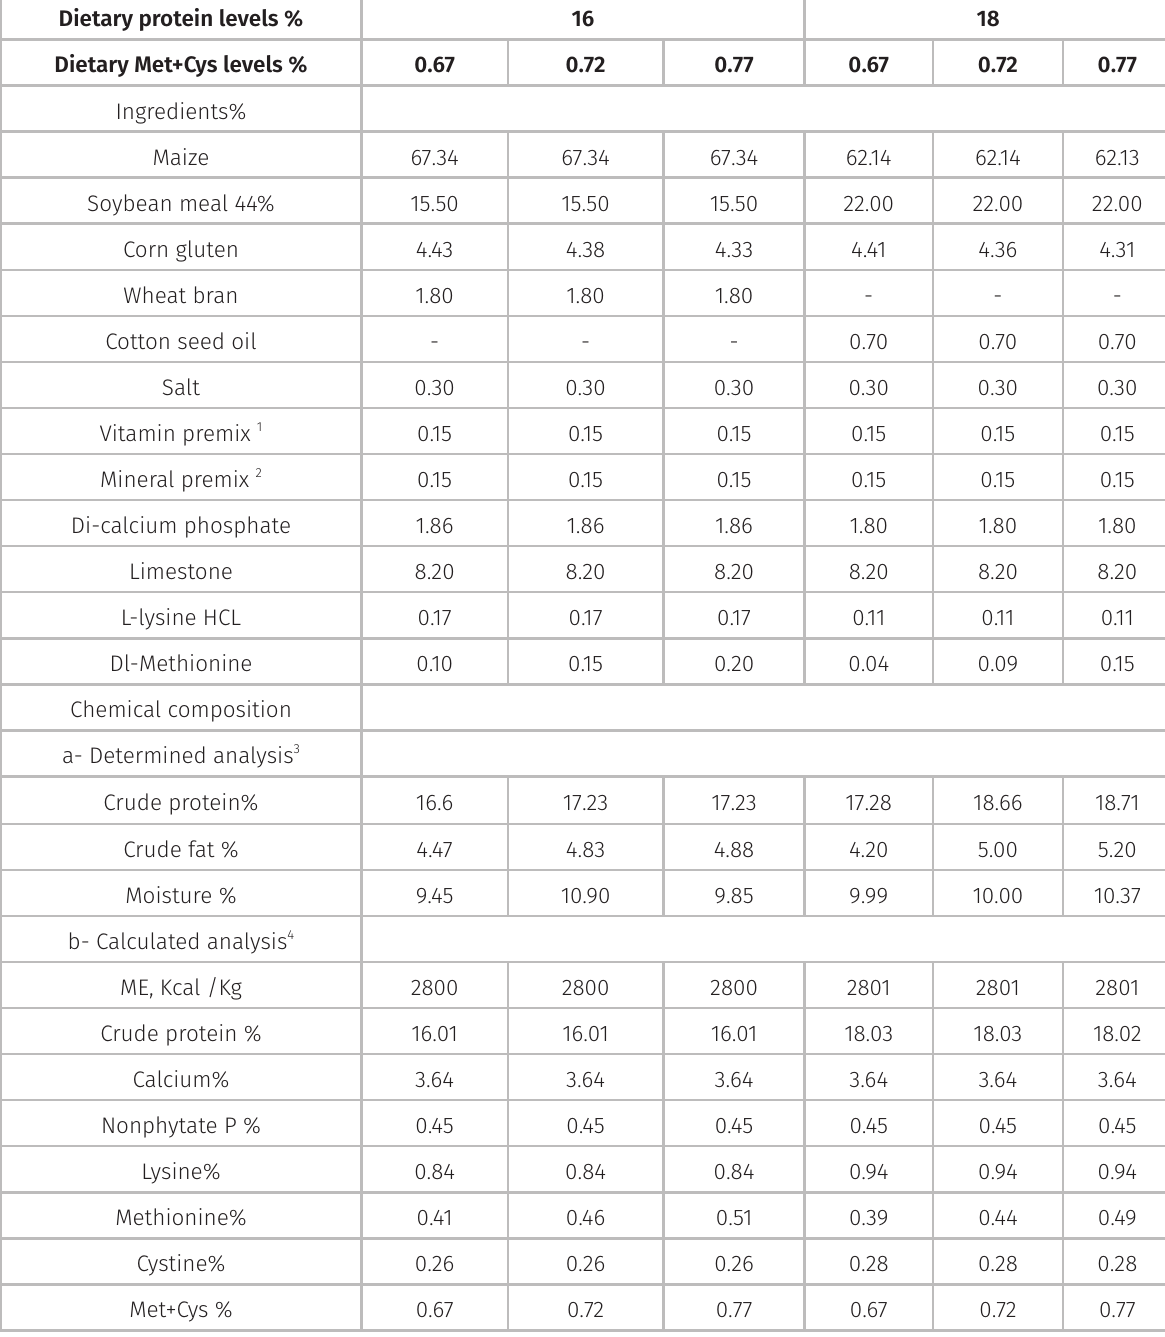
Table I. Composition and chemical analysis of the experimental diets. Dietary protein levels % Dietary Met+Cys levels